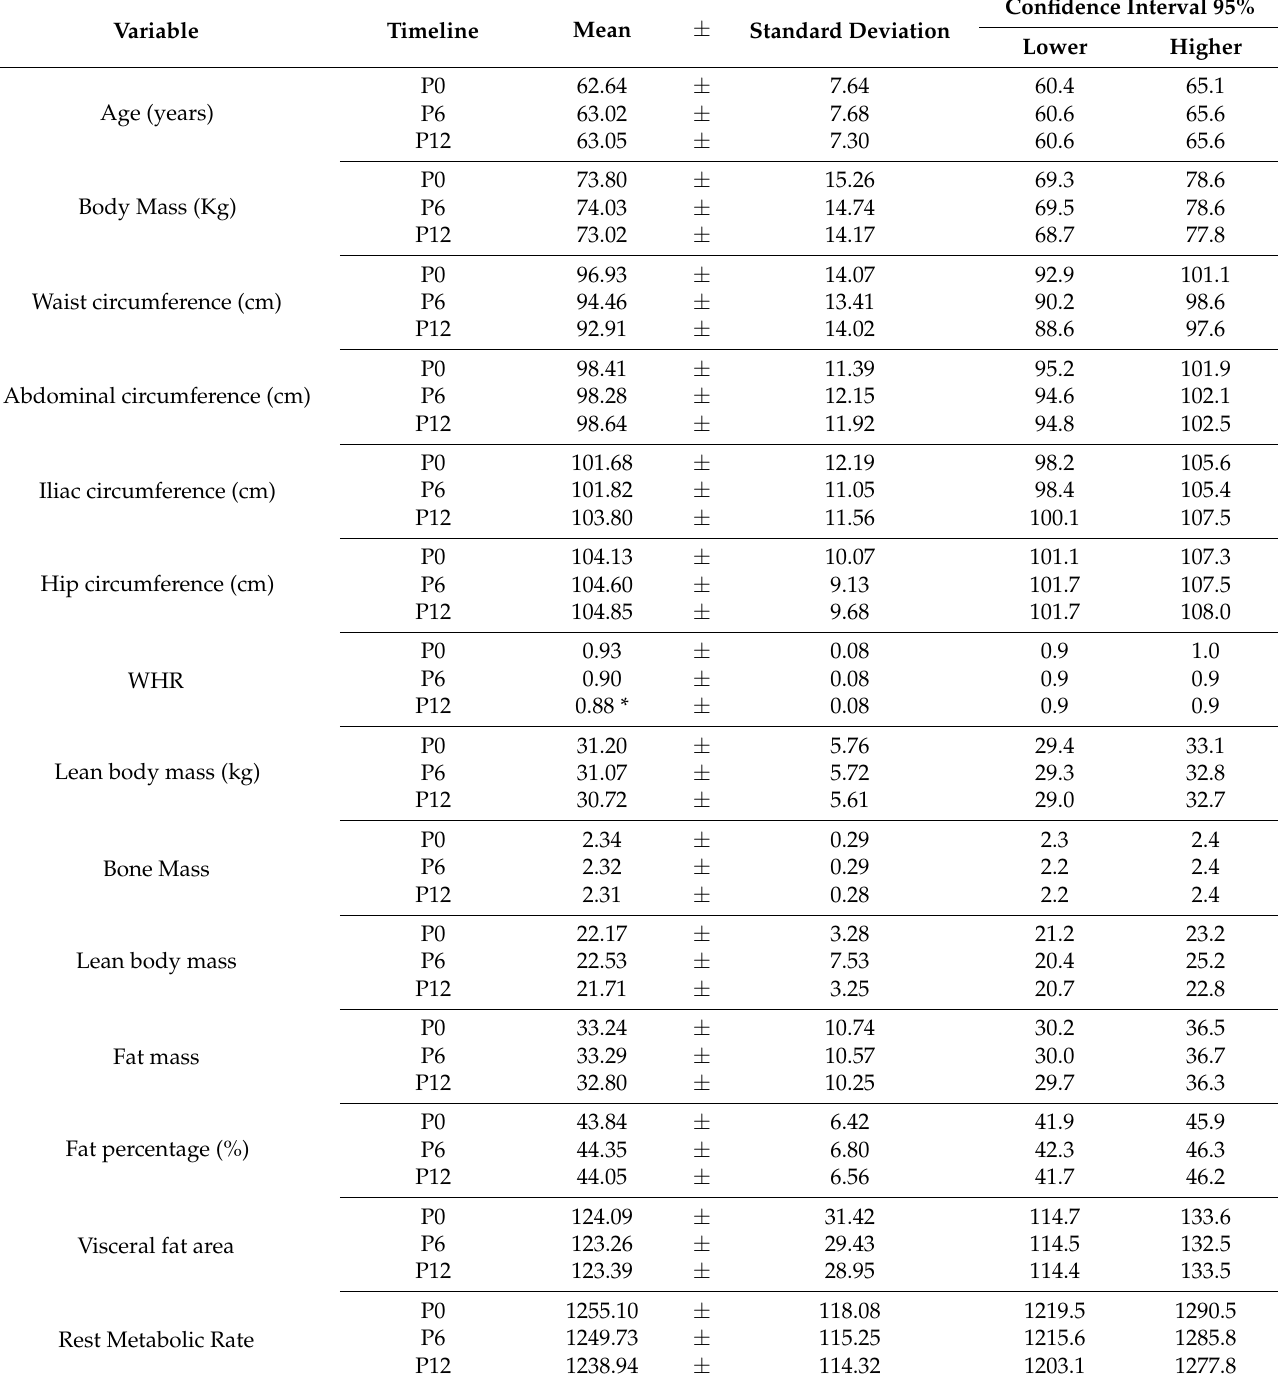
Table 2. Secondary Outcomes